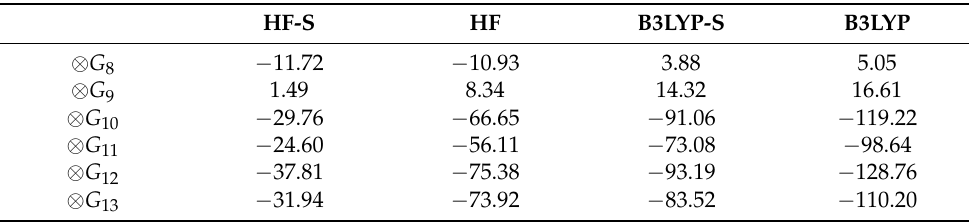
Table 3. Reaction free energy comparison for various computational methods for the reaction pathways 8–13 in Figure